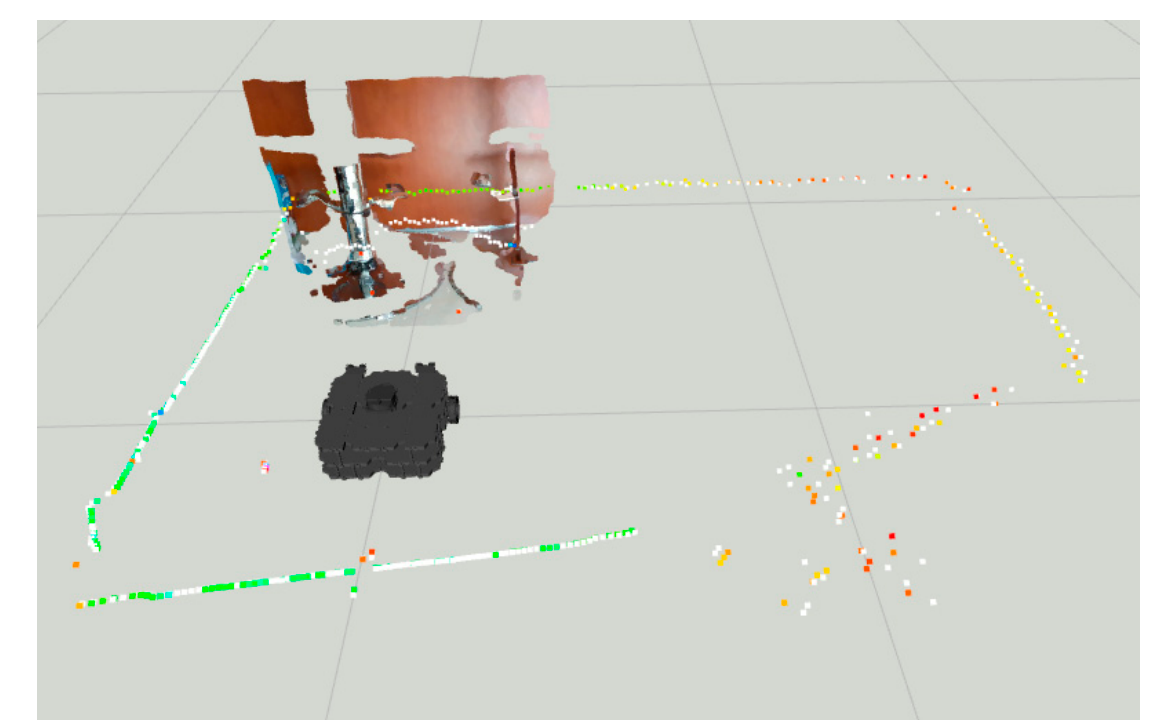
Figure 23. All sensors scanning region for LiDAR-Sonar-Camera fusion.